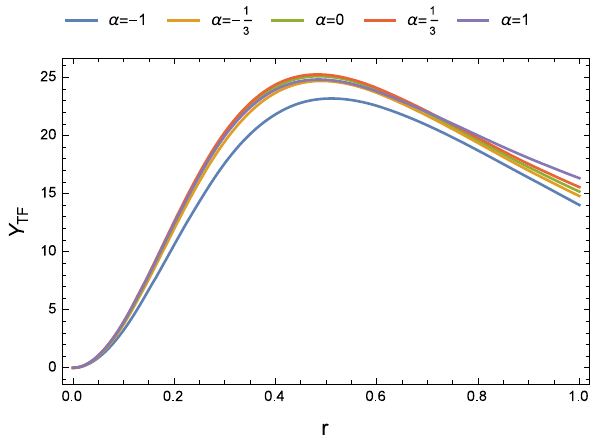
Fig. 3 Y TF vs the radial coordinate r for K = − 1000 and varying α